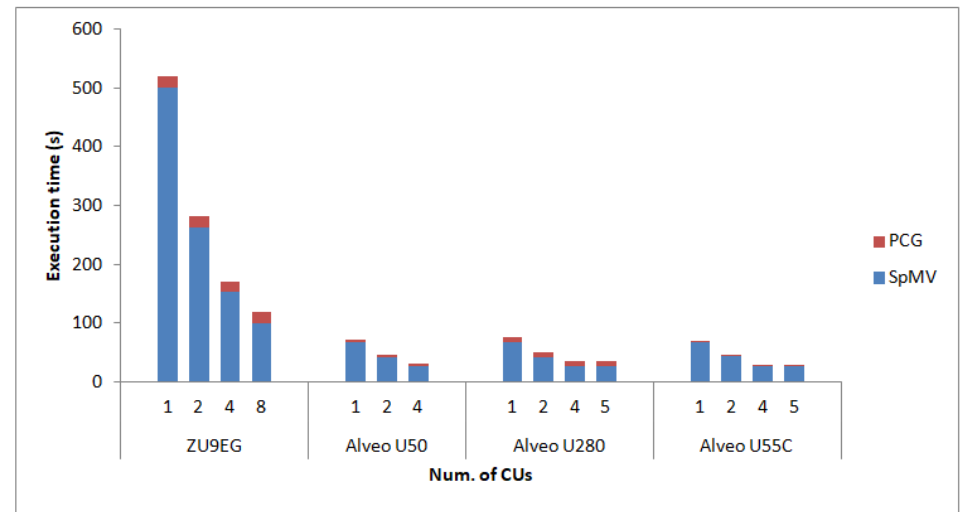
Figure 4. Test case Emilia_923—execution time of 100 iterations of PCG on different hardware varying the number of CUs. The time of the PCG and the corresponding SpMV products are highlighted in red and blue,